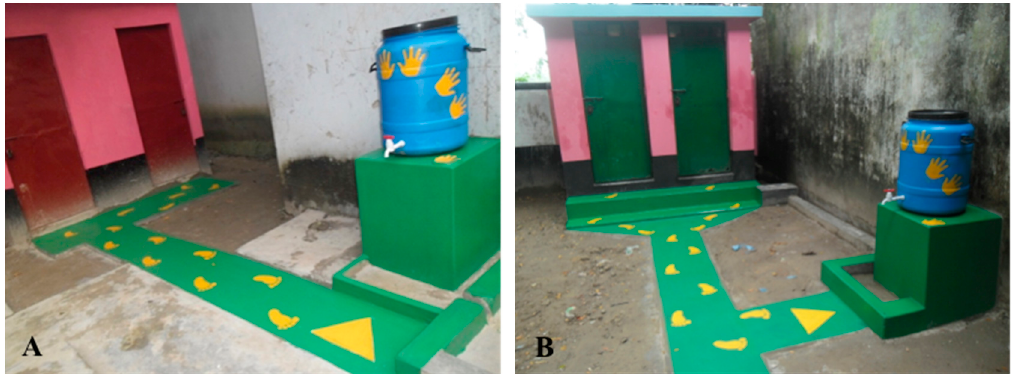
Figure 2. Nudges following final phase of construction, including: dedicated handwashing station, paved paths, and painted foot—and handprints in School ( A ) and School ( B ) (photo taken immediately following construction and prior to soap being made available during the next school day).